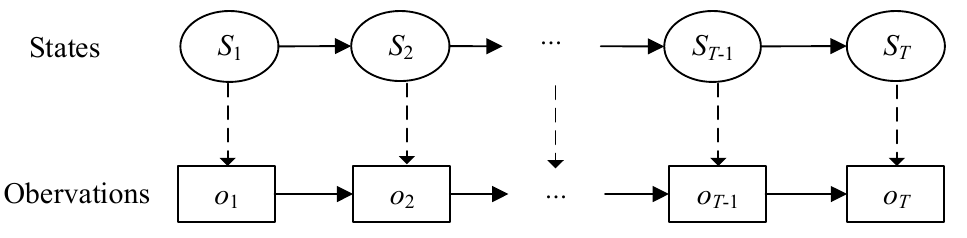
Figure 2. The construction of the IHMM.